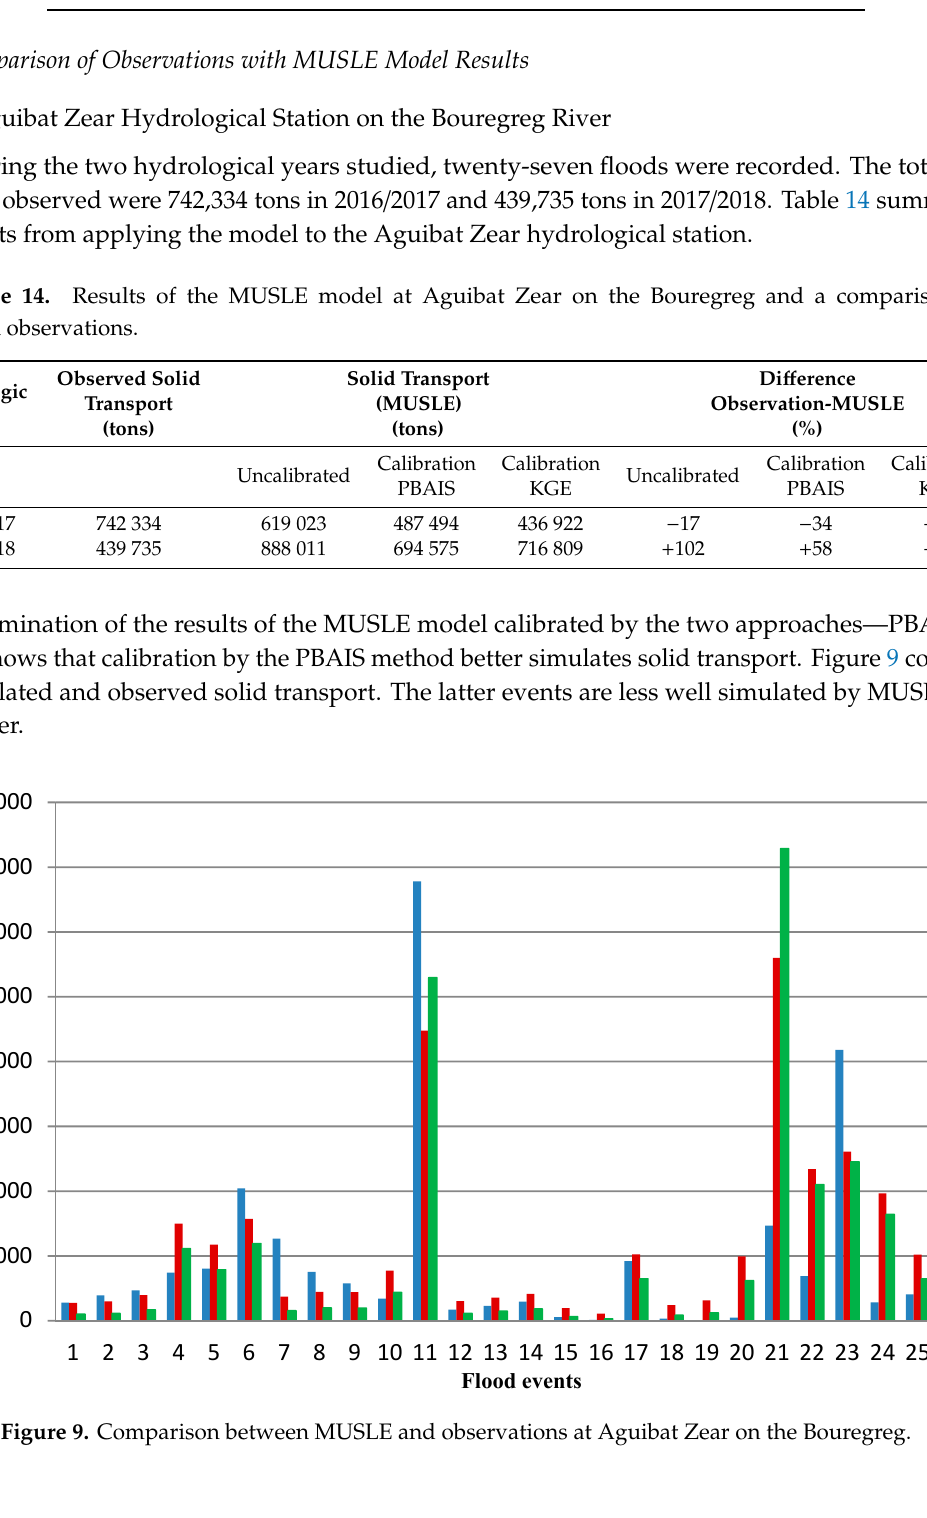
Figure 9. Comparison between MUSLE and observations at Aguibat Zear on the Bouregreg.